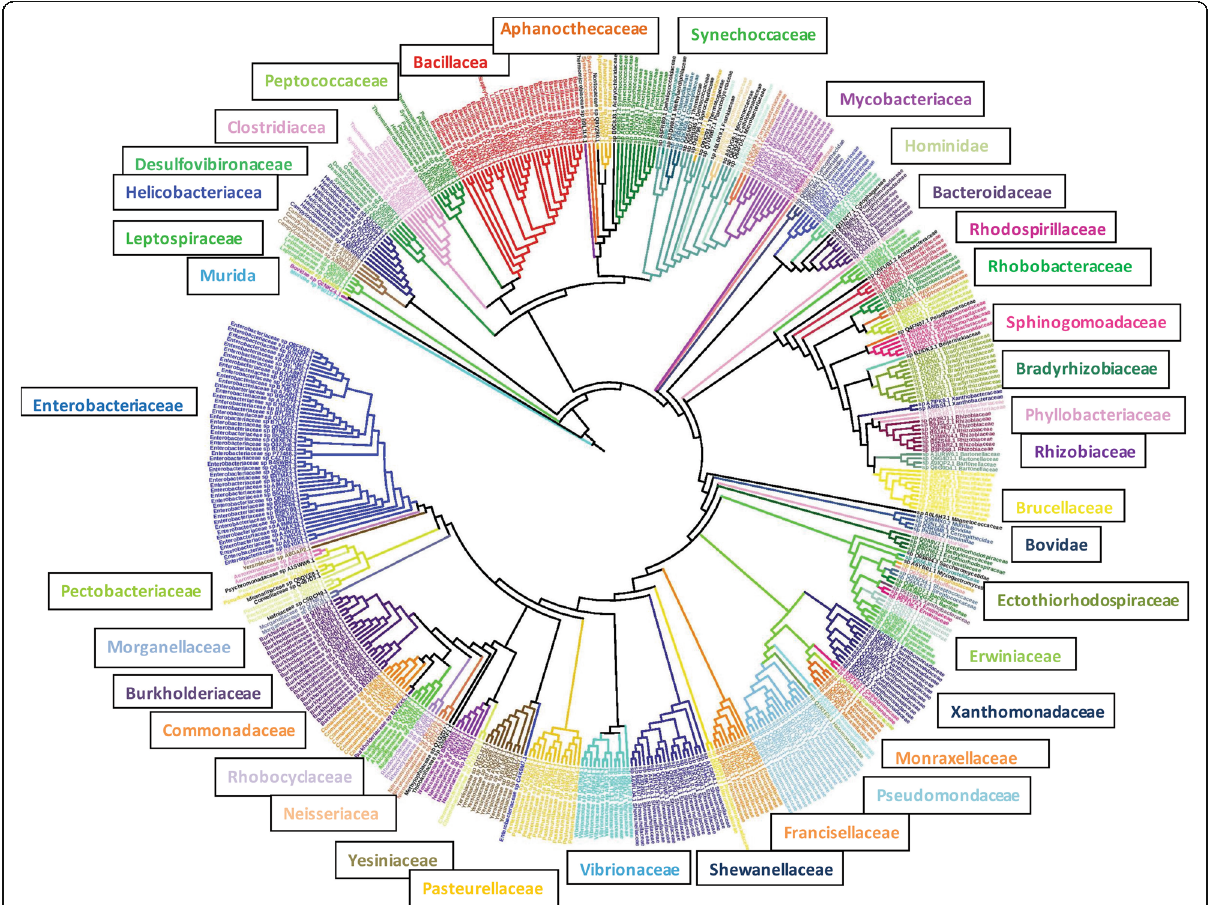
Fig. 7 Phylogenetic tree of the 546 sequence dataset of DXP synthase. An average pairwise score of 1.012 within the range of 1.0175 to 2.876 is